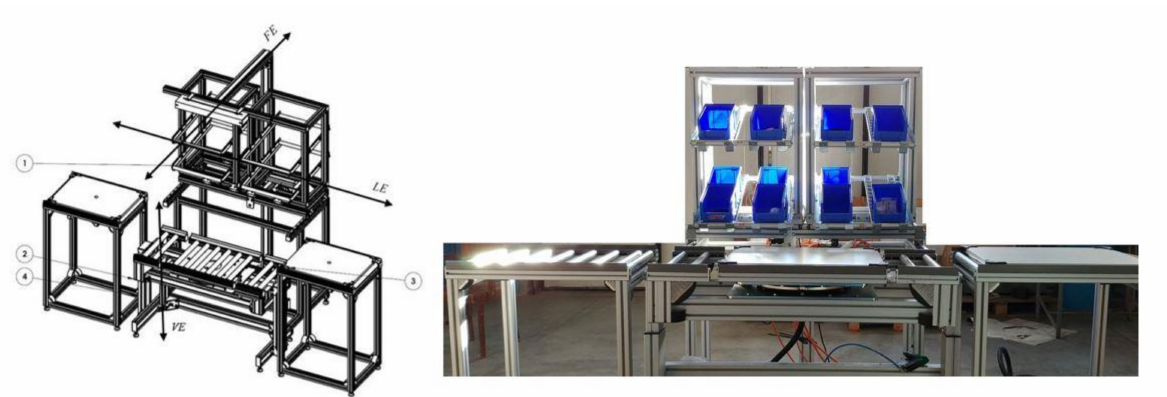
Figure 3. 3D layout and real picture of the SASAS prototype: 1. Fast-picking zone for the storage of the assembly parts; 2. Extendable supports of the main roller conveyor; 3. Lateral roller conveyor; 4. Main roller conveyor ( left ), and a real image of the assembly prototype ( right ). Motion axes: Lateral Extension (LE), Frontal Extension (FE), Vertical Extension (VE).